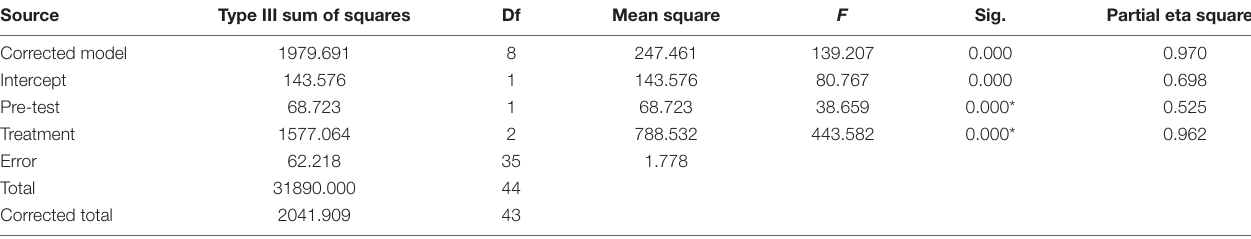
TABLE 1 | Analysis of covariance of post-attention span of children with intellectual disability by treatment. Source